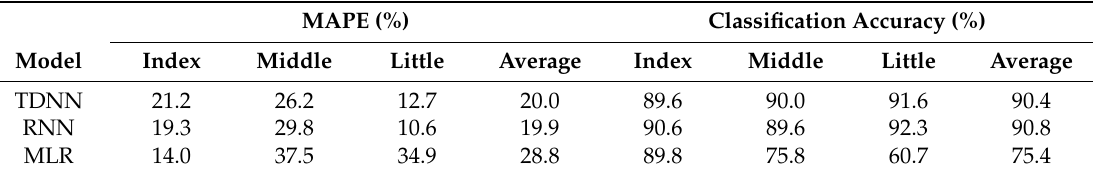
Table 2. 10-step-ahead prediction performance of seven-fold cross-validation for the three models that were evaluated.